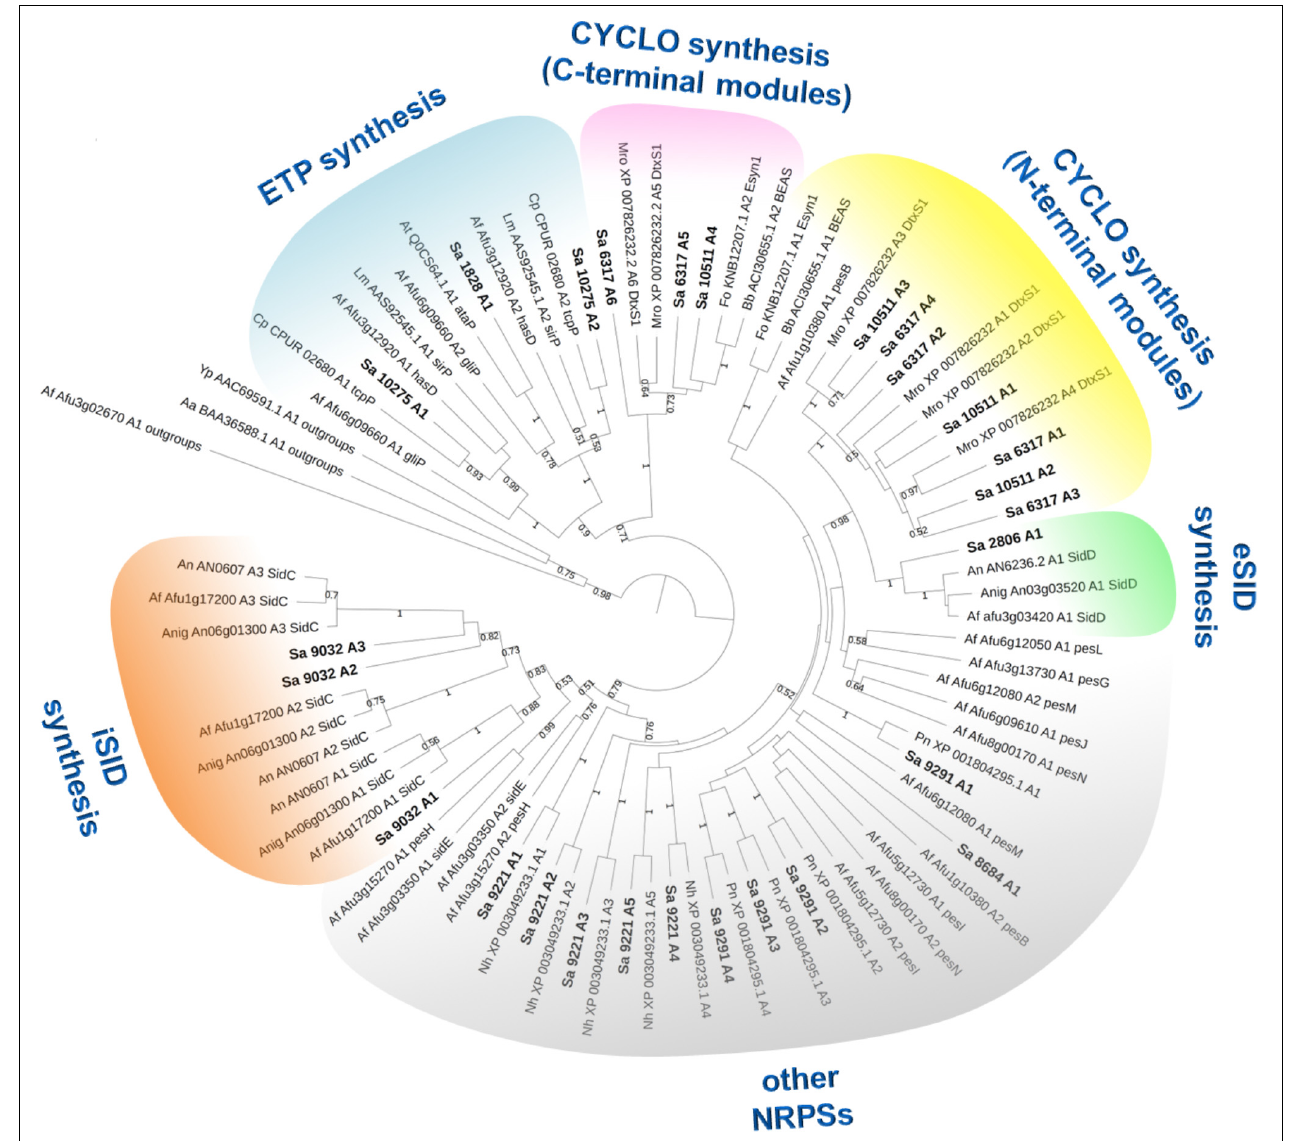
FIGURE 2 | Maximum likelihood phylogenetic tree (PhyML + LG model) from reduced A-domain dataset. Bootstrap values greater than 50% are shown below branches. This analysis shows several clades which globally superimpose with the biological function, i.e., epidithiodioxopiperazines (ETP), extracellular siderophores (eSID), intracellular siderophores (iSID), cyclopeptides (CYCLO) and other unassigned NRPSs. Among the few discrepancies, both A-domains of sidE and pesH cluster with intracellular siderophores A-domains, although these NRPSs are not involved in the biosynthesis of